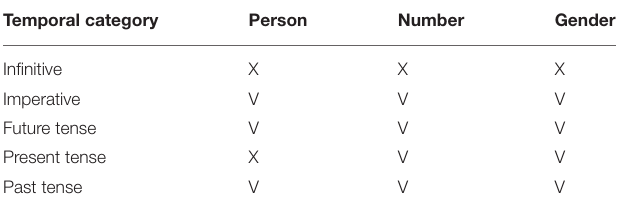
TABLE 2 | Subject-verb agreement in Hebrew